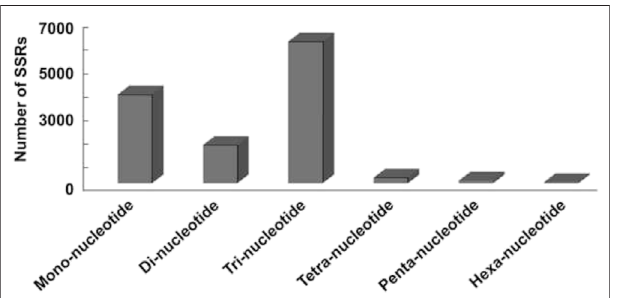
FIGURE 5 | Distribution of SSRs observed in this study. X-axis represents SSRs repeat motif type. Y-axis represents number of SSRs.